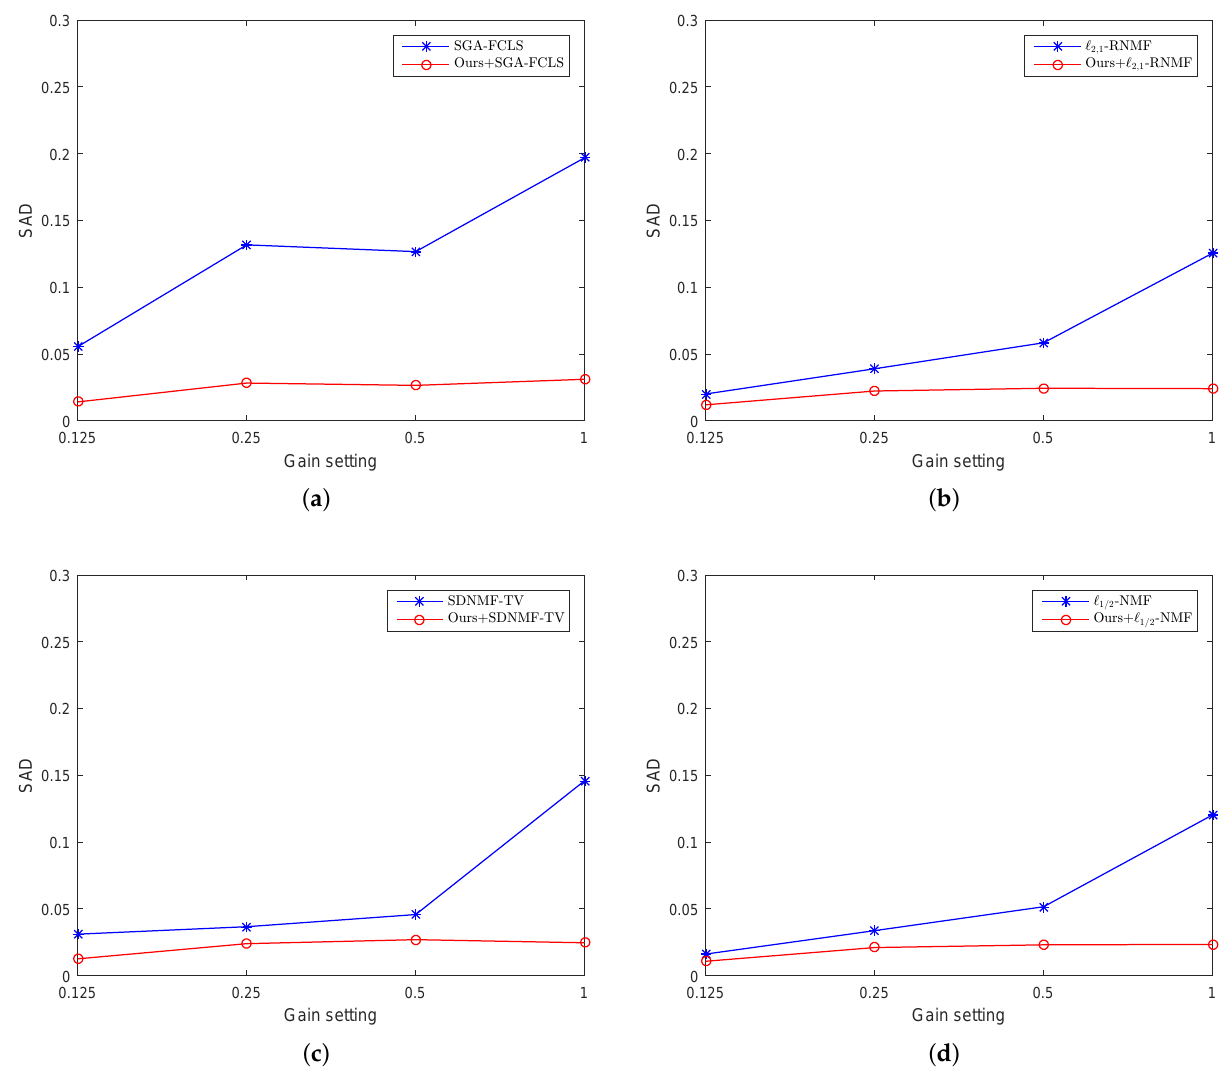
Figure 7. The SAD results of unmixing algorithms with/without our proposed method under different gain settings. ( a ) SGA-FCLS. ( b ) (cid:96) 2,1 -RNMF. ( c ) SDNMF-TV. ( d ) (cid:96) 1/2